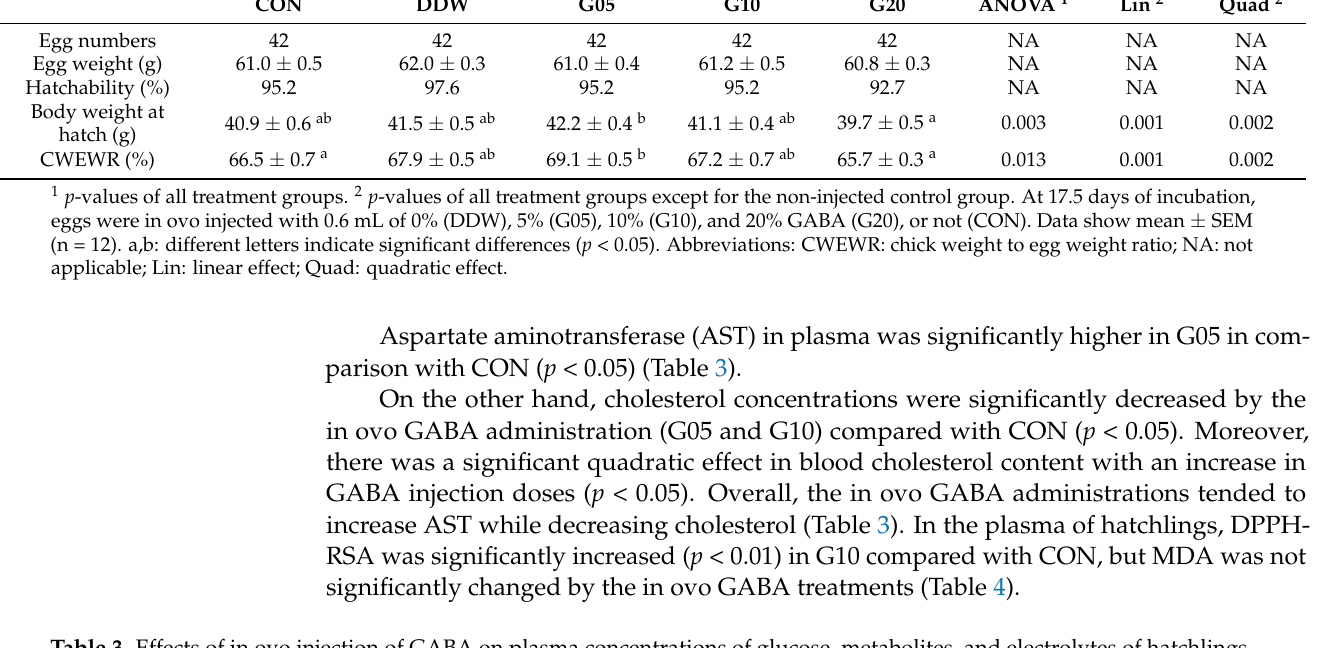
Table 3. Effects of in ovo injection of GABA on plasma concentrations of glucose, metabolites, and electrolytes of hatchlings.